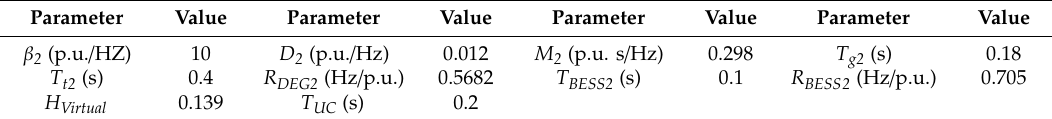
Table 3. Parameters of microgrid 3.